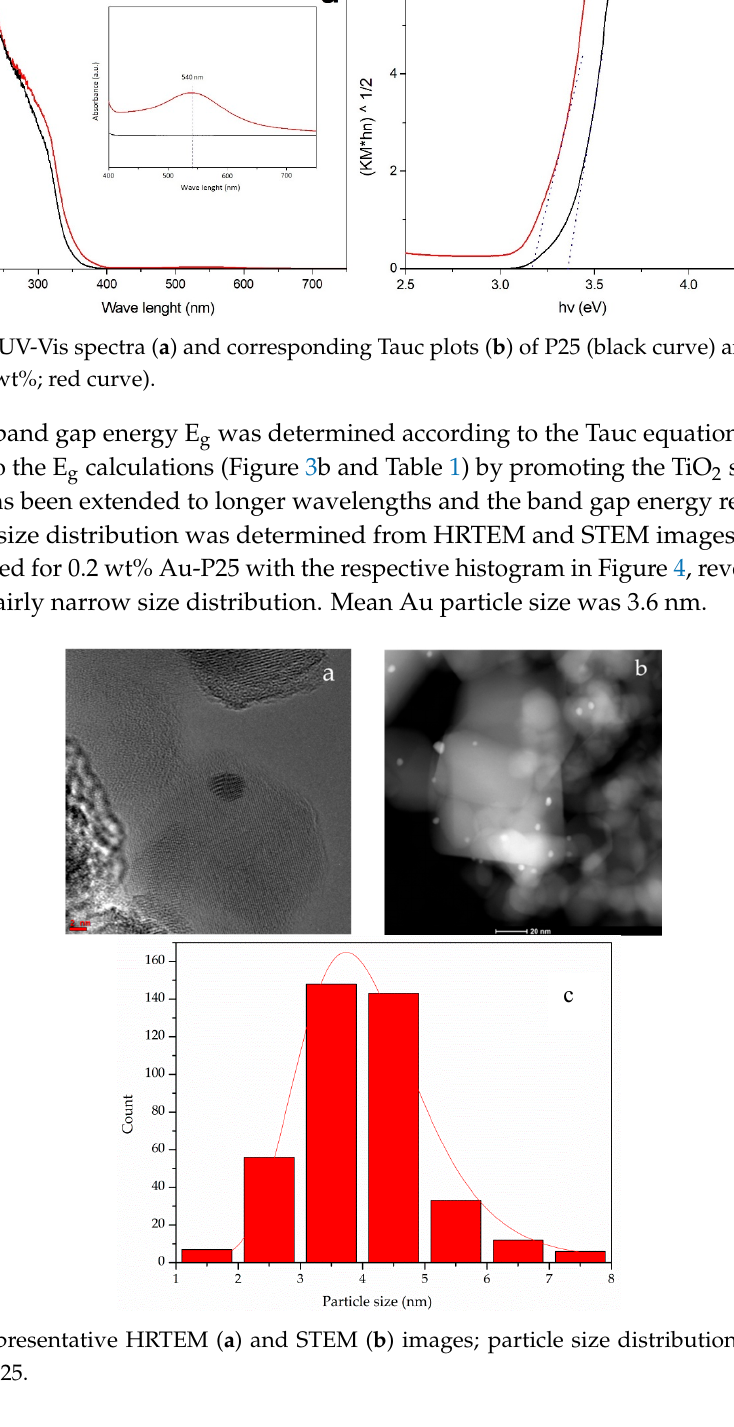
Figure 2. N 2 adsorption/desorption isotherms collected at − 196 °C over samples outgassed overnight at 150 °C, P25 (squares), FSP (triangles).